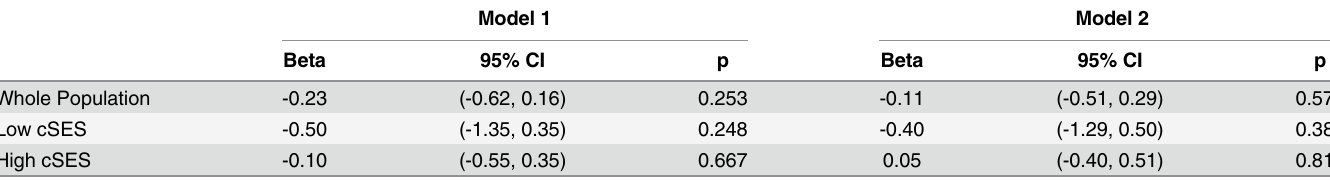
Table 2. Results for number of depressive symptoms among GI Bill eligible veteran wives compared to non-veteran wives.